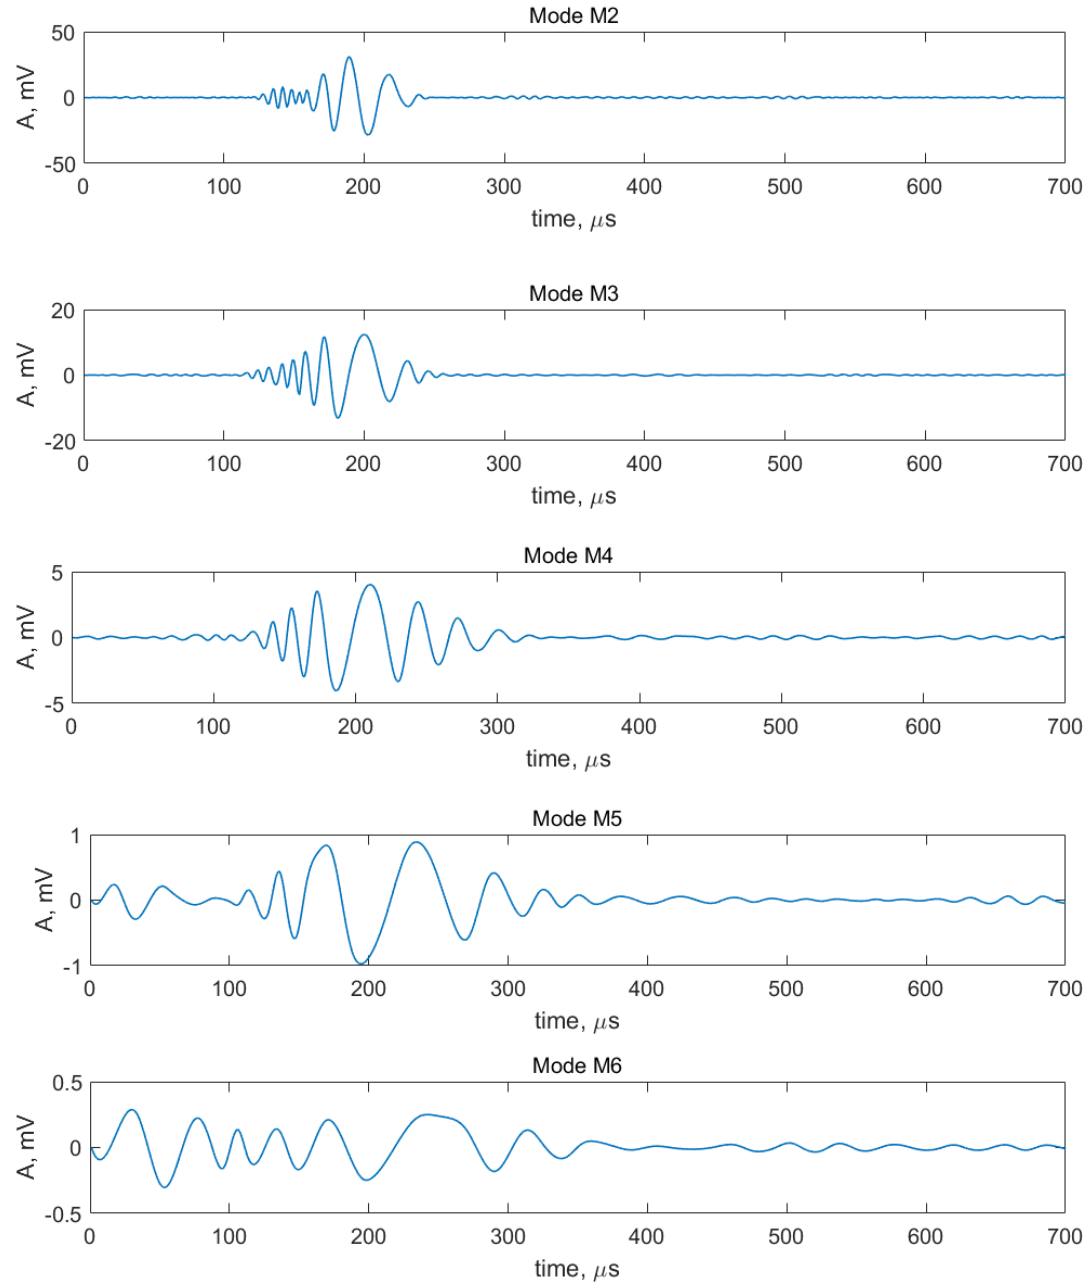
Figure 14. Decomposition of a signal into empiric modes (the first six out of 15 modes are